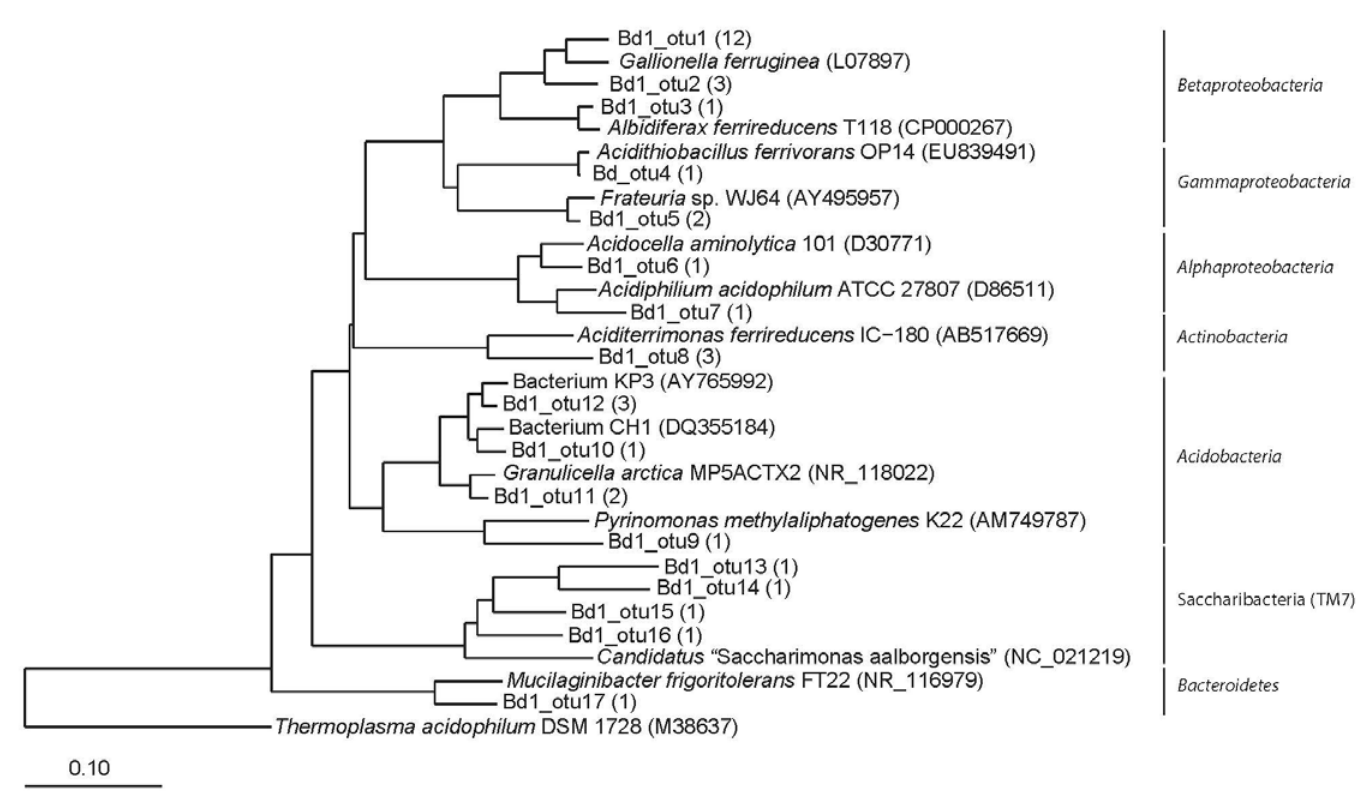
Figure A2. Phylogenetic affiliation for the 16S rRNA gene sequences obtained from the Bjørndalen library (Bd1). Representative clones for different phylotypes were selected, retrieved from the sediment and water springing from the waste pile. A maximum parsimony tree was chosen as a consensus tree after reconstructing the phylogeny by using different algorithms, substitutions models, and filters. Related isolates or environmental sequences are shown for comparison purposes. Bar represents 10% estimated phylogenetic